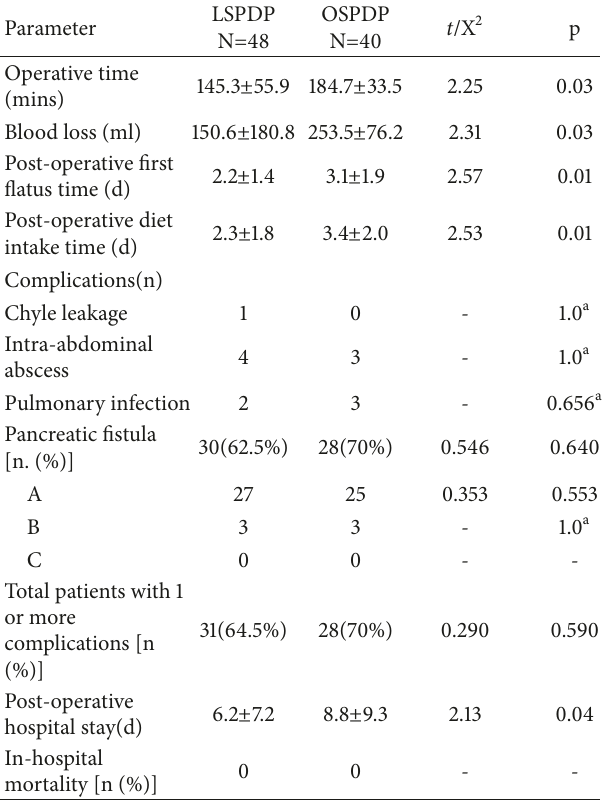
Table 3: Intraoperative and postoperative data and